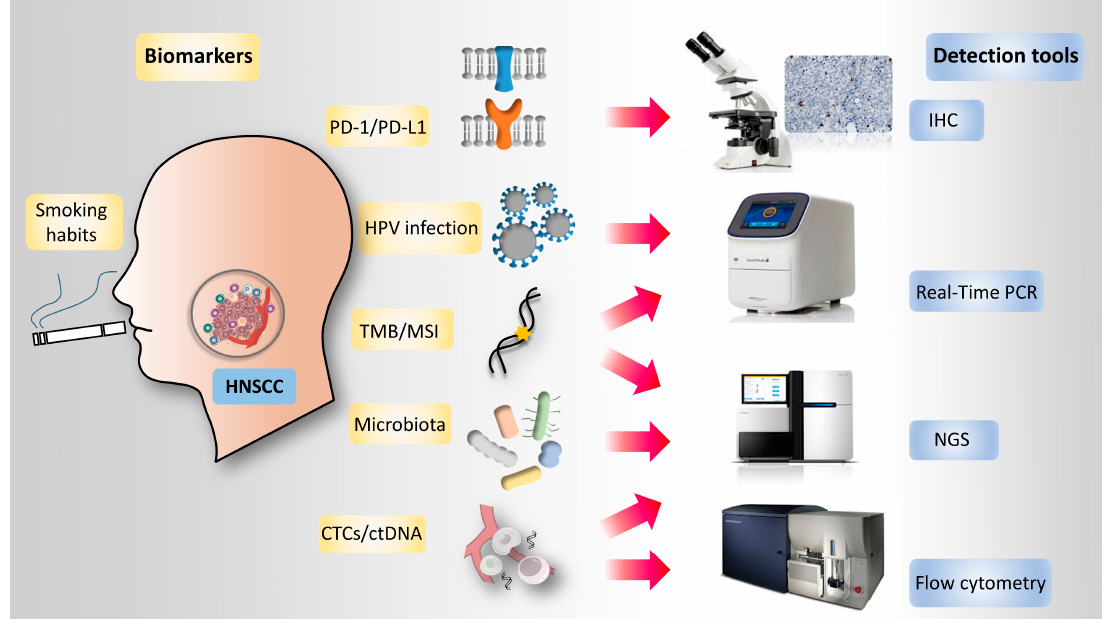
Figure 1. Current and emerging biomarkers for prediction of the clinical e ffi cacy of immune checkpoint inhibitors (ICIs) in head and neck squamous cell carcinoma (HNSCC). Several host- or tumor-related markers have been demonstrated to be able to predict the clinical e ffi cacy of ICI treatment. Advances in molecular analysis have also provided valuable predictive information such as tumor mutational burden (TMB) and status of microsatellite instability (MSI). Other markers, including circulating tumor cells (CTCs), circulatingtumorDNA(ctDNA),andgutororalcavitymicrobiotaarealsobeinginvestigated. CTC, circulating tumor cells; ctDNA, circulating tumor DNA; HNSCC, head and neck squamous cell carcinoma; ICIs, immune checkpoint inhibitors; MSI, microsatellite instability; TMB, tumor mutational